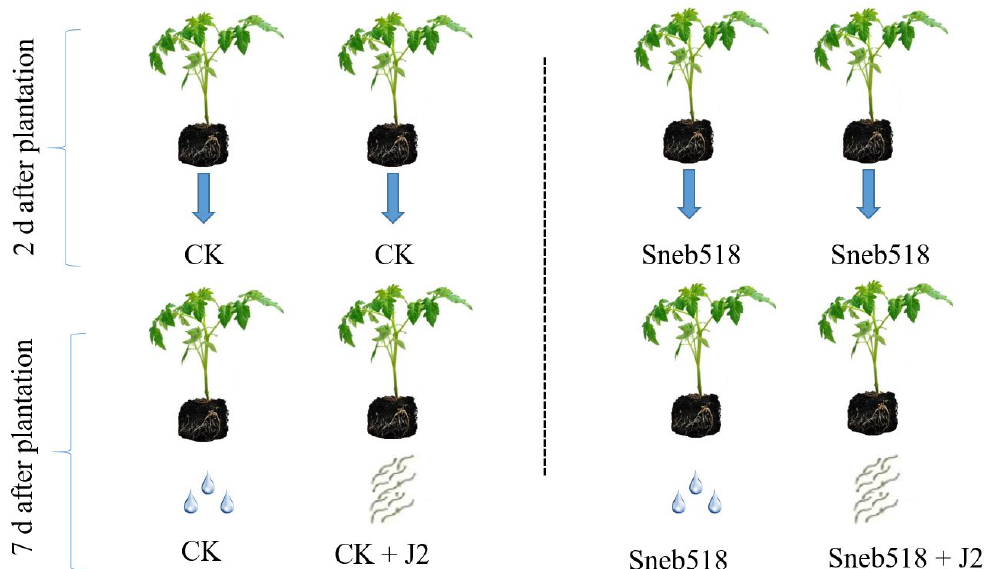
Figure 1. Effect of Sneb518 on the control of M. incognita in the pot experiments. A total of four treatments were used. After 2 days of the plantation, the half-plant was inoculated with 20 mL 10× diluted Sneb518 fermentation (Sneb518), while the other half served as a control and was inoculated with sterilized water (CK). After 7 days of the plantation, the 2000 J2s were inoculated into half of the Sneb518 (Sneb518+J2) and half of the control plants (CK +J2).